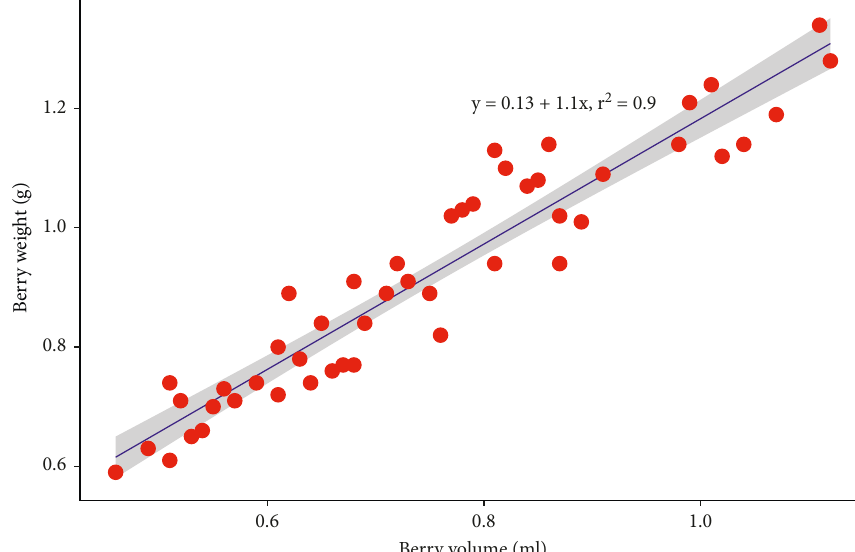
Figure 4: Correlation between grapevine berry volume and weight.